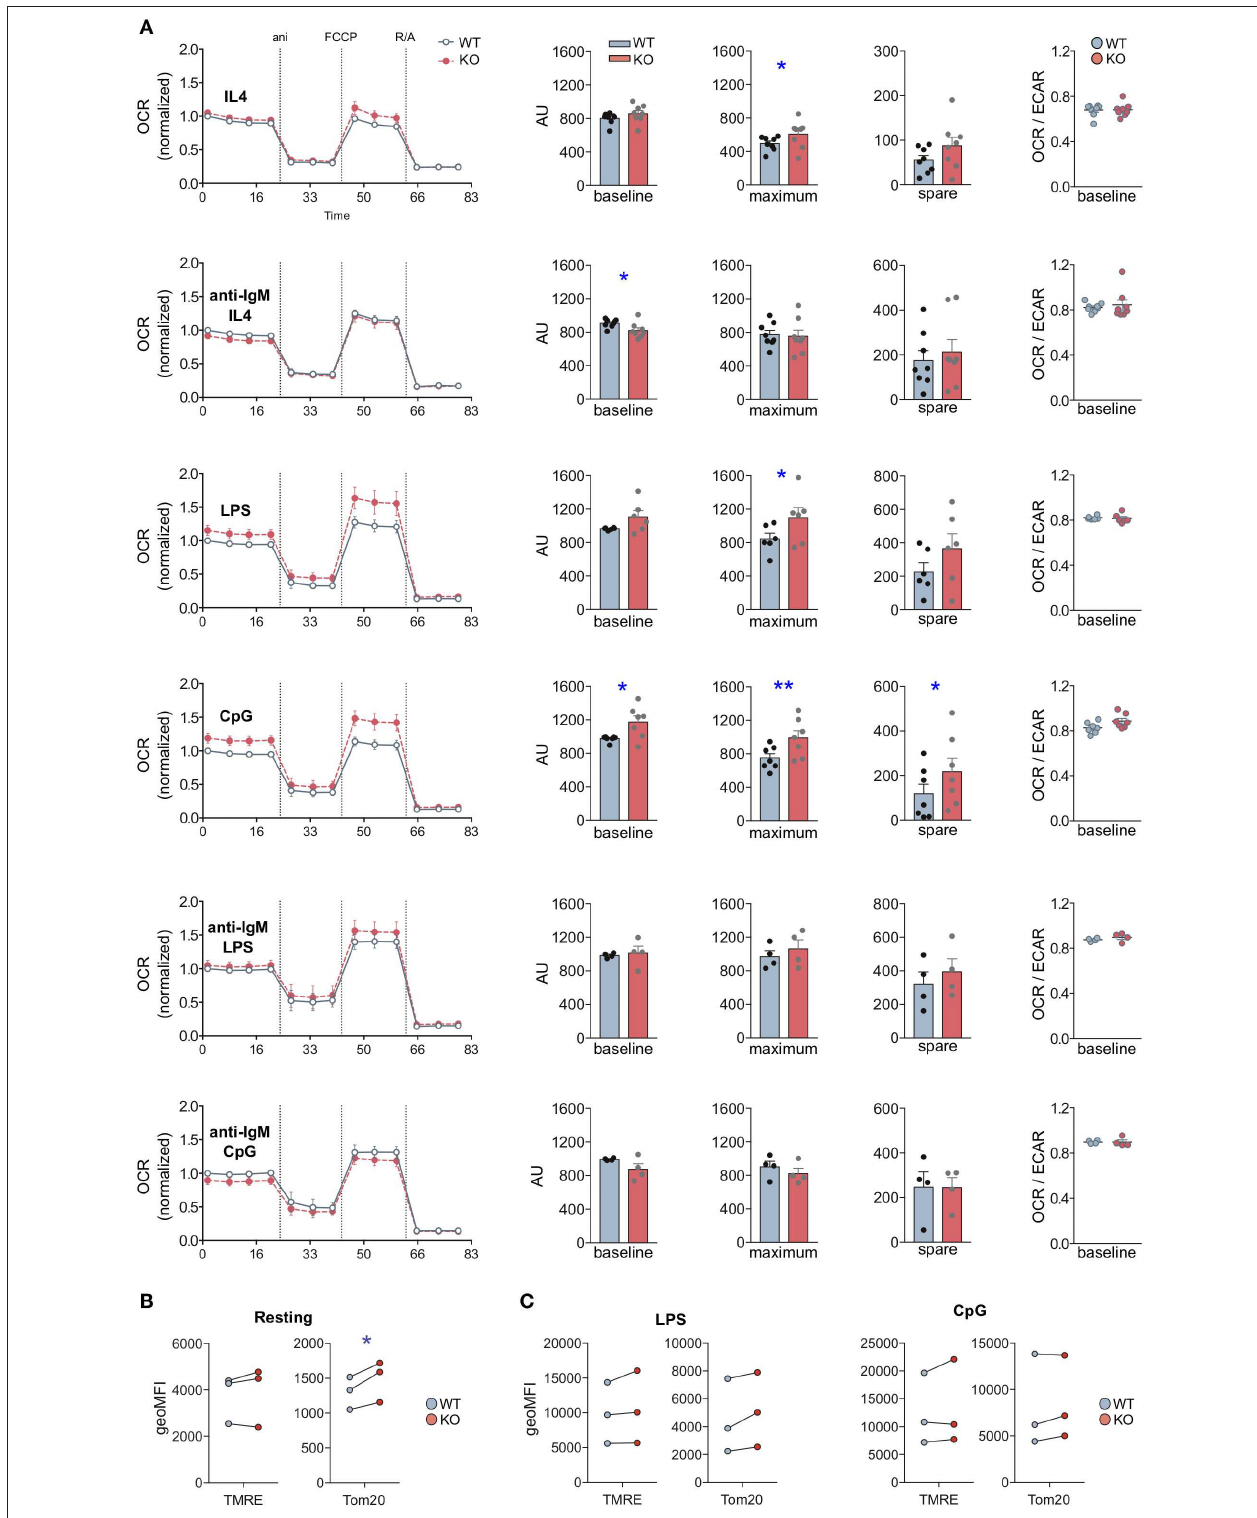
FIGURE 5 | MIM-deficient B cells show increased metabolic activity upon stimulation with Toll-like receptor ligands LPS and CpG. (A) Oxygen consumption rate (OCR) profiles of WT and MIM-KO splenic B cells stimulated with IL-4, anti-IgM + IL-4, LPS, CpG, anti-IgM + LPS, or anti-IgM + CpG for 24h were measured